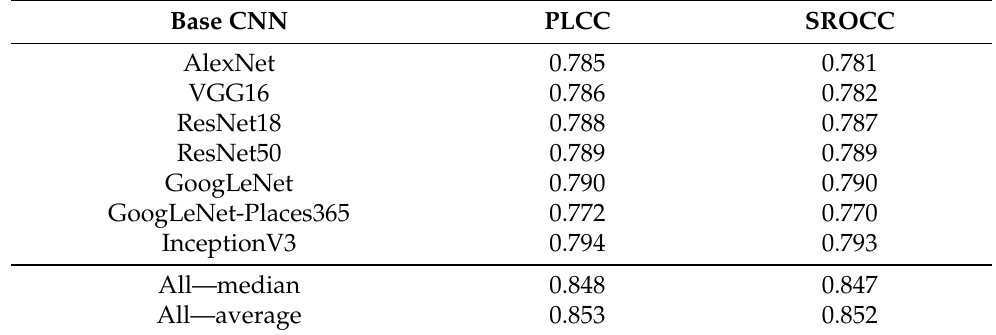
Table 6. Performance of different base architectures and decision fusion methods using GAP layers for feature extraction and GPRs with rational quadratic kernel function for regression. Median PLCC and SROCC were measured over 1000 random train–test splits.